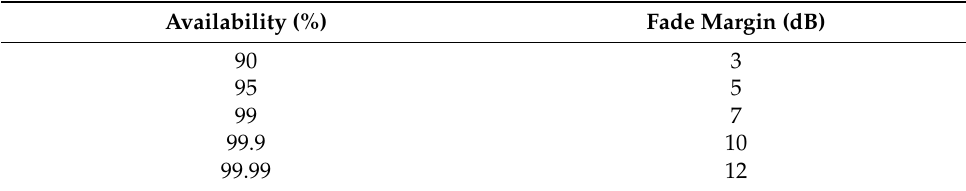
Table 3. Fade margin for MIMO based Rayleigh fading